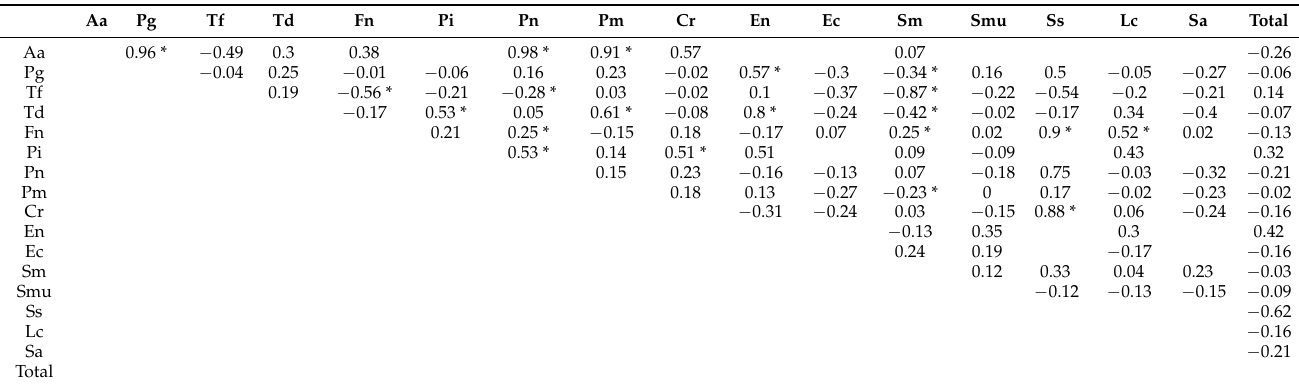
Table 4. Interspecies correlations in all subjects.